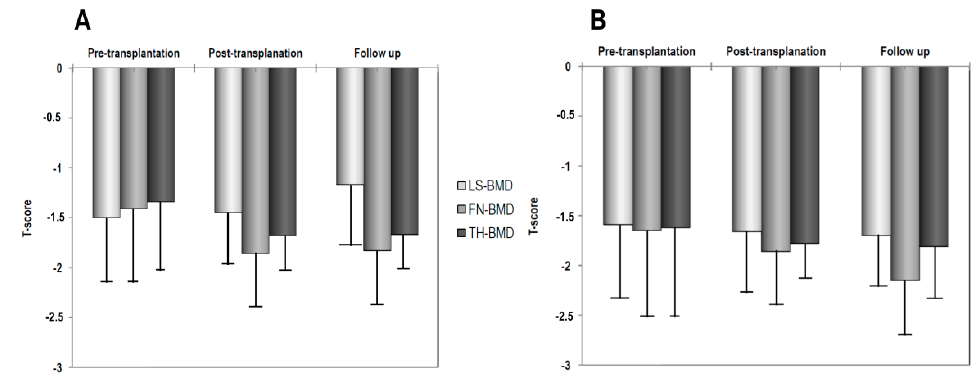
Figure 2. T-score values at pre-transplantation, post-transplantation, and follow up in lung ( A ) and heart recipients ( B ).